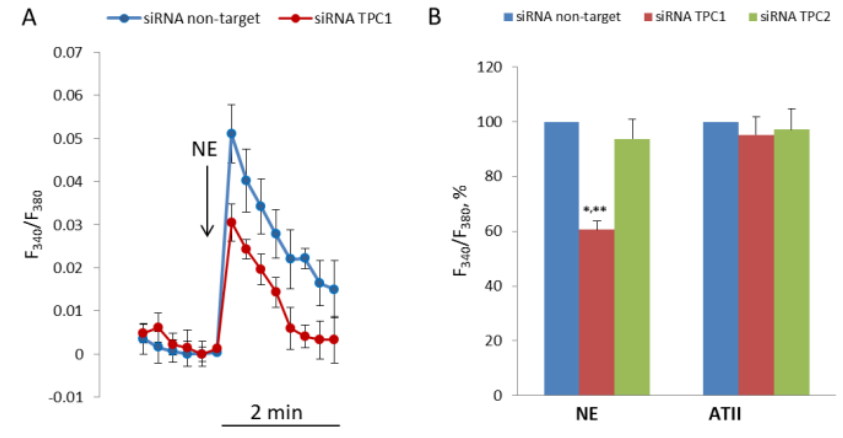
Figure 6. Decrease in [Ca 2+ ] i rise in response to NE in SMCs transfected with siRNA against TPC1. ( A ) Kinetics of [Ca 2+ ] i rise in SMCs transfected with siRNA against TPC1 and nontarget siRNA. The curves from one of four transfection experiments are presented. Each point at the curves is an average of six parallel measurements. ( B ) Calcium responses to NE (100 μM) and angiotensin II (0.1 μM) in SMCs transfected with nontarget siRNA, and siRNA against TPC1 and against TPC2. [Ca 2+ ] i rise in SMCs transfected with nontarget siRNA is taken as 100%. The mean values + SEM from four independent transfection experiments with different SMCs preparations are presented. There is significant difference between the responses of SMCs transfected with anti-TPC1 siRNA and with nontarget (** p < 0.01) or anti-TPC2 siRNA (* p < 0.05).